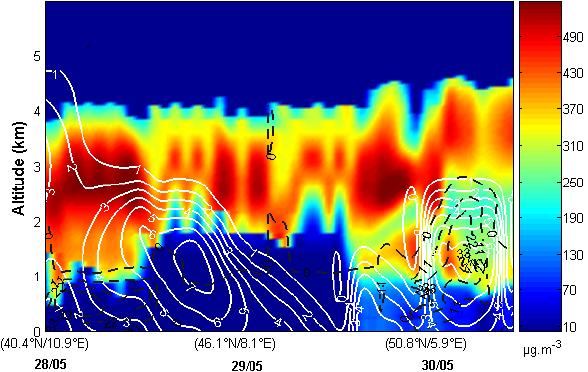
Figure 7. Vertical cross section of dust mass concentration (shad- ing) with carbonaceous component mass concentration (white line, BC and OC) and inorganic salts mass concentration (black dashed line) following the dust plume trajectory over Europe between (40.4 ◦ N, 10.9 ◦ E) and (56.6 ◦ N, 8.0 ◦ E) obtained from the simu- lation.